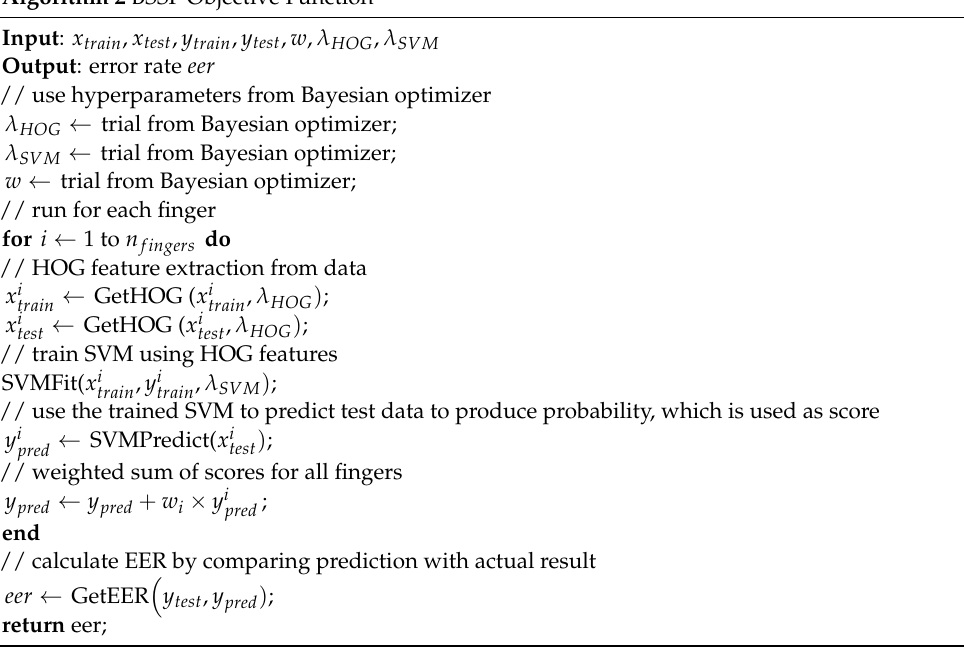
Algorithm 2 BSSF Objective